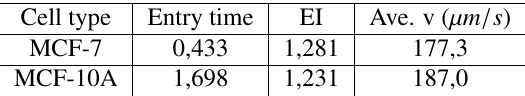
Table 4. Values measured in biological experiment